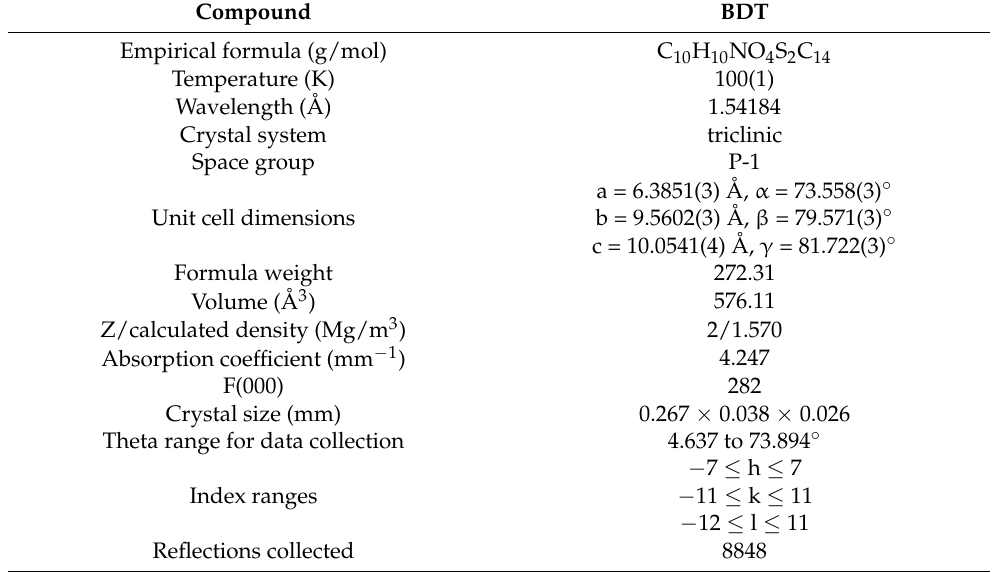
Table 1. Crystal data and structure refinement for